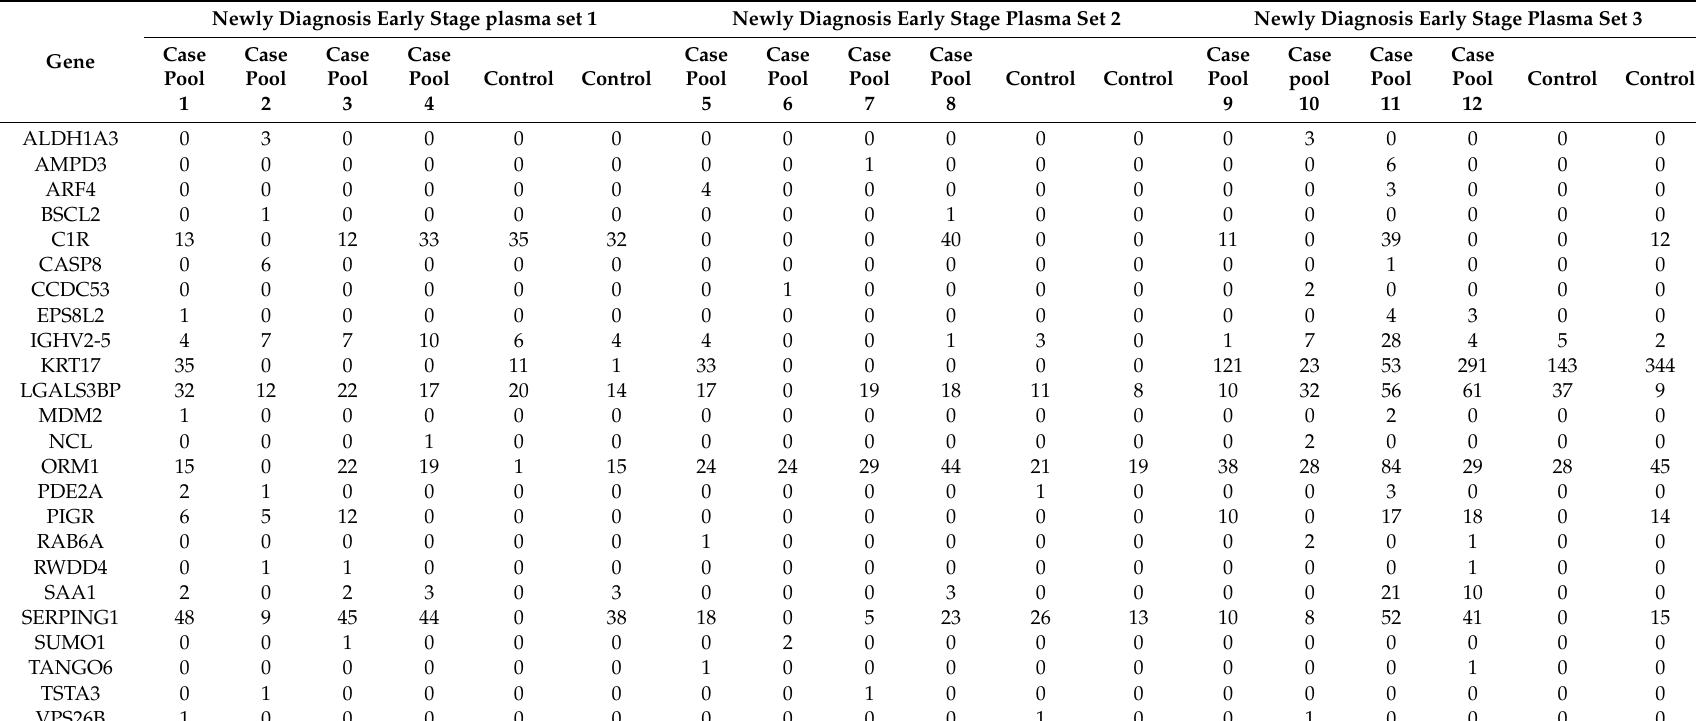
Table 2. Ig-bound proteins in early stage ovarian cancer. Number indicates mass spectral